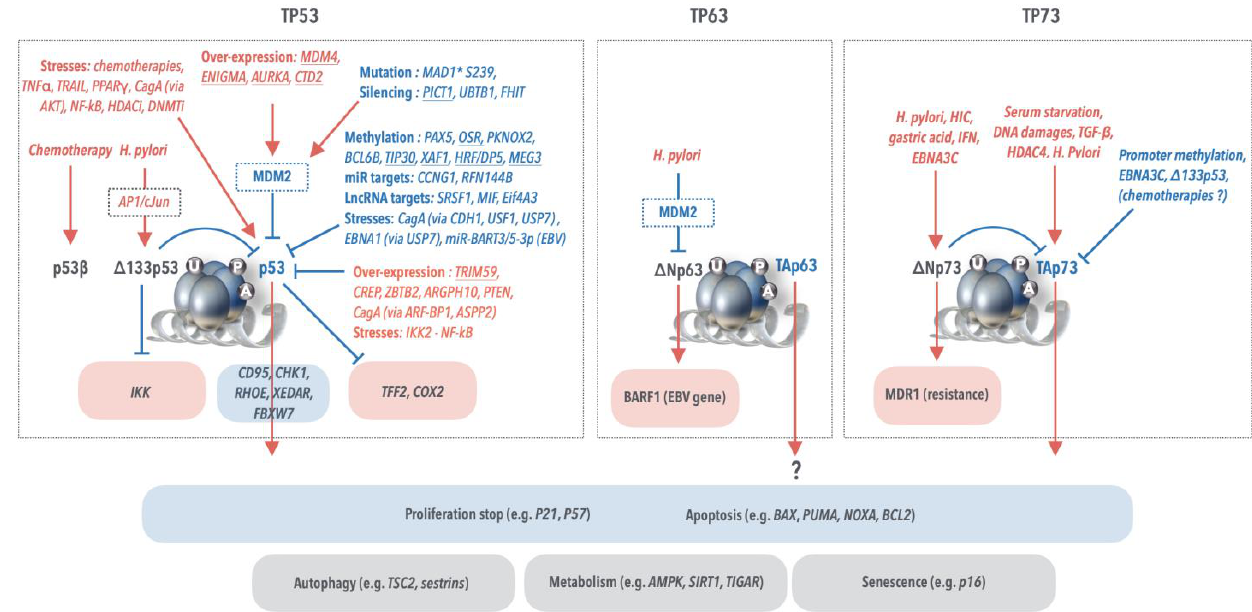
Figure 4. Signals and mechanisms affecting the expression and activity of the isoforms of the p53 family in gastric cancer. Activators are indicated in red and repressors in blue. Underlines indicate existing clinically relevant data.